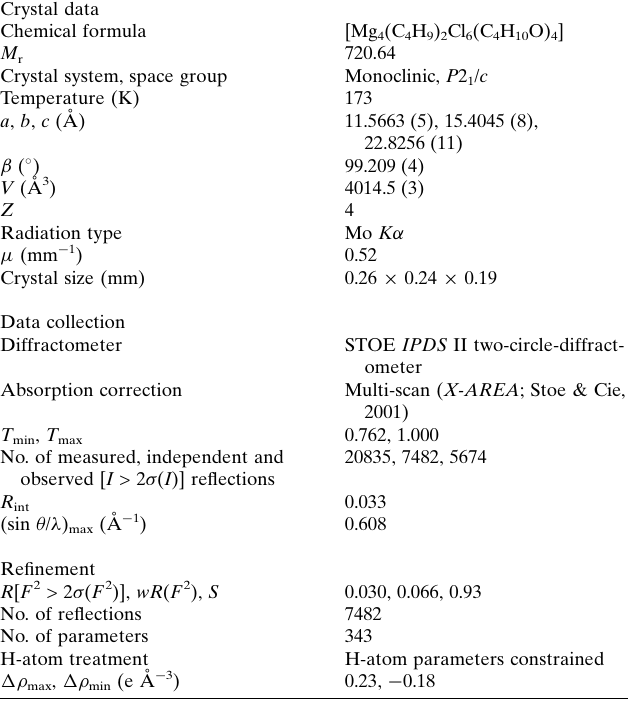
Figure 4 Packing diagram of the title compound II showing the C—H (cid:3)(cid:3)(cid:3) Cl hydrogen bonds (cyan) between adjacent molecules of II . H atoms not involved in hydrogen bonding are omitted for clarity.